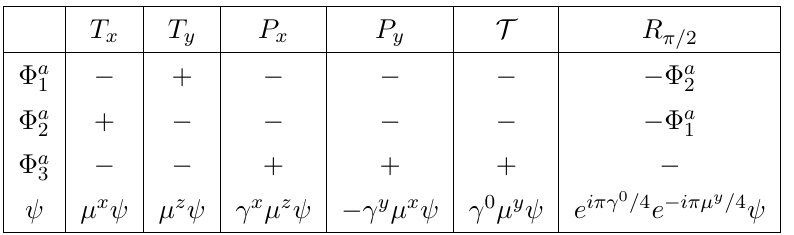
Table 1 . Listed are the microscopic symmetries of the square lattice and their action on the continuum fields. T ( P ) indicate translations (reflections) along the i ’th axis, T is time-reversal i i symmetry, and R is a π/ 2 rotation. We omit the action of SU(2) spin rotation symmetry as its π/ 2 action on the fermions ψ is non-trivial and described in the main